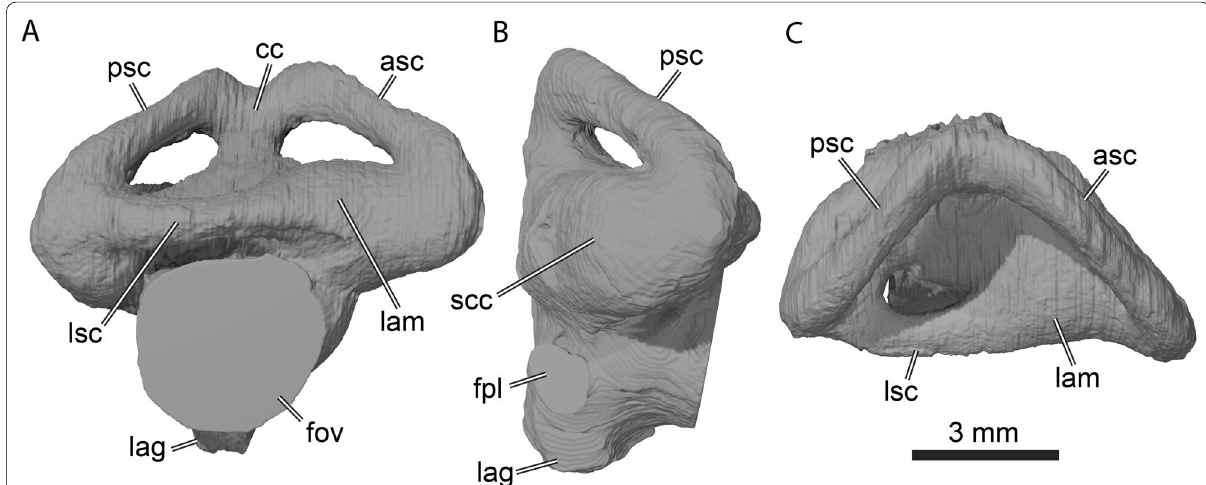
Fig. 9 3D rendering of the right endosseous labyrinth of UCM 53971. A Lateral view, B posterior view, C dorsal view. asc anterior semicircular canal, cc common crus, fov fenestra ovalis, fpl fenestra perilymphatica, lag lagena, lam lateral ampulla, lsc lateral semicircular canal, psc posterior semicircular canal, scc secondary common